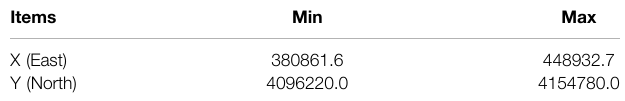
Frontiers in Earth Science |